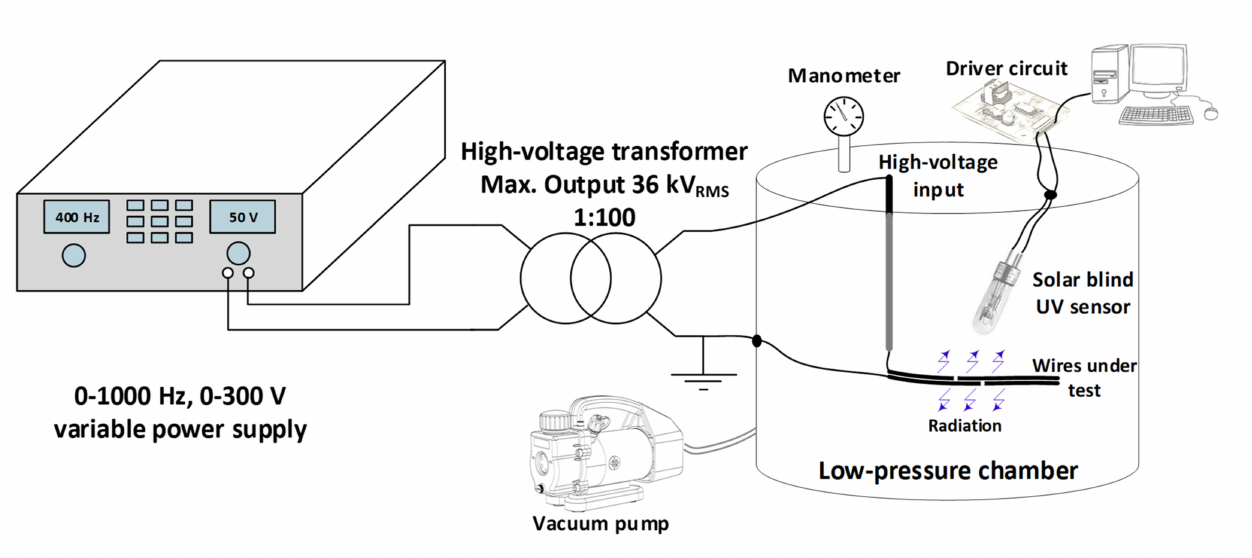
Figure 3. Sketch of the experimental layout used to detect the UV light emitted by the electrical discharges in the very initial stage using a solar blind UV sensor in the 10–100 kPa range using a low-pressure chamber connected to the high-voltage transformer and the vacuum